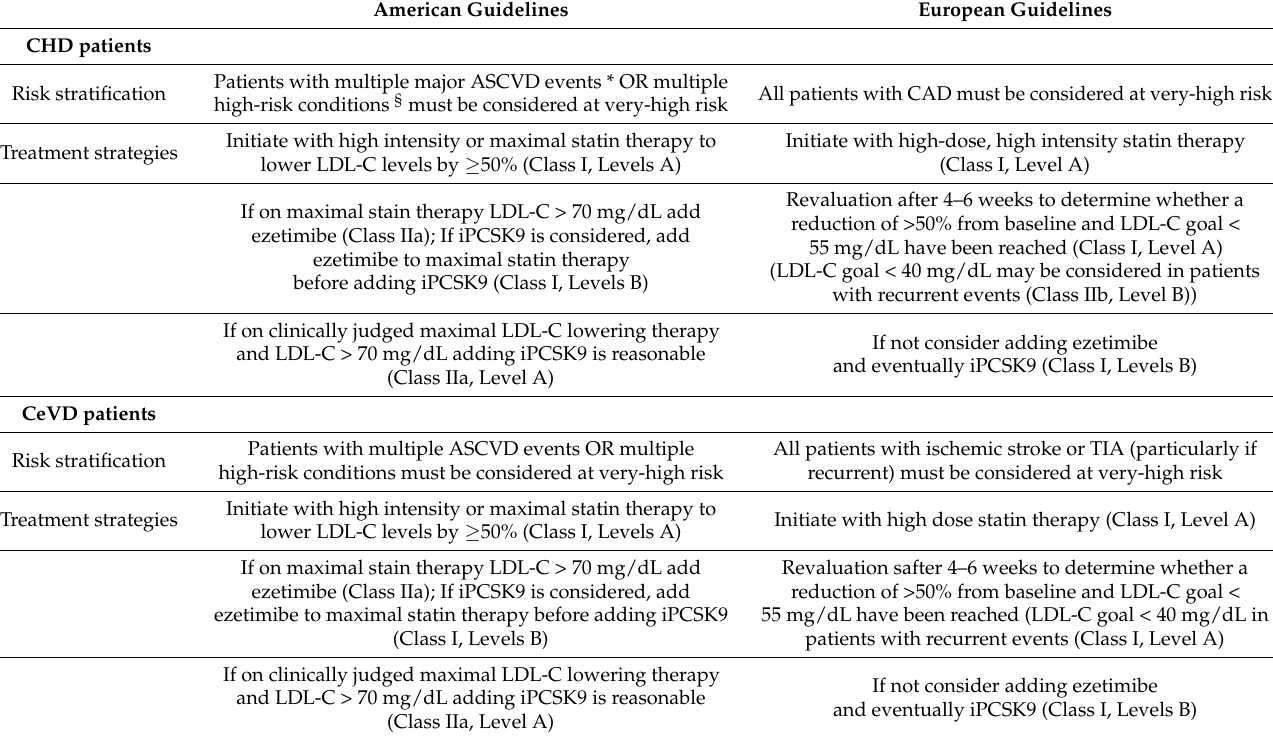
Table 3. Comparison of LDL-C lowering strategies in CAD and CVD patients as recommended by the American and European